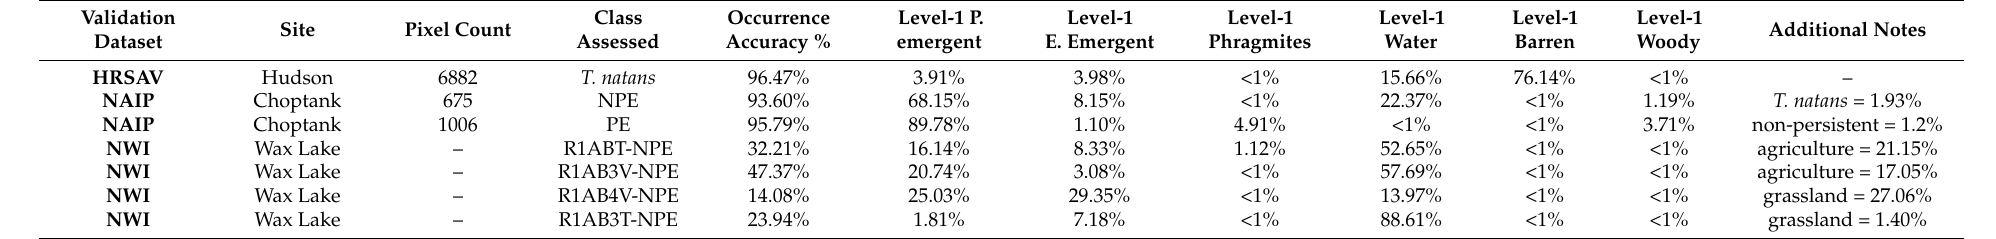
Table 6. Level-2 accuracy assessment for Hudson River T. natans , Choptank River non-persistent emergent (NPE) and persistent emergent (PE), and Wax Lake Delta NPE classifications (four NWI classes). Occurrence accuracy percent serves as classification performance